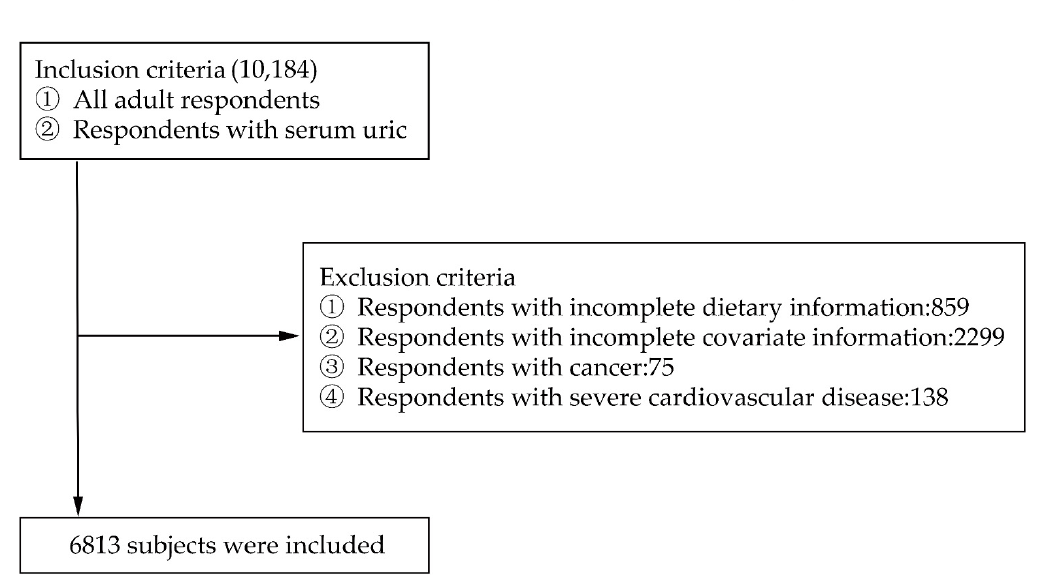
Figure 1. Flow chart for inclusion and exclusion of research subjects.